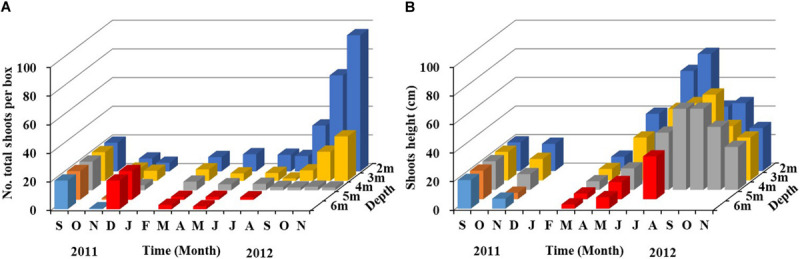
Temporal changes in Z. marina shoot density (A) and shoot height (B) along a depth gradient in Ailian Bay in a shoot transplantation experiment beginning in September 2011. Since Z. marina was not found at 5 m and 6 m in December 2011, 20 shoots per box were re-transplanted at 5 m and 6 m (red column). The values in the figure represent the means.